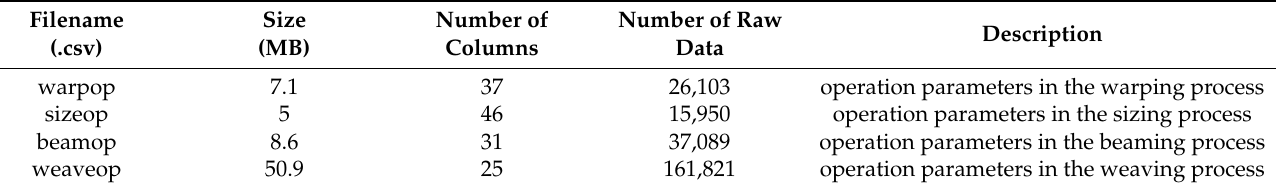
Table 4. Manufacturing dataset.